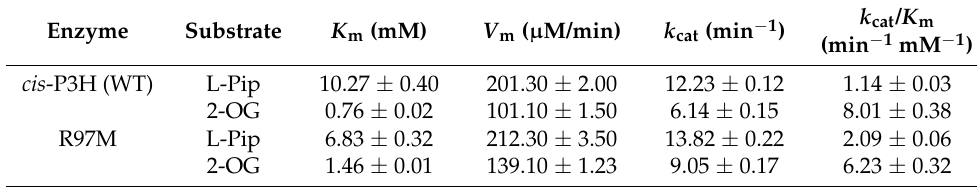
Figure 6. Catalytic performance of the positive mutant and the WT. The blue column represents the results under crude enzyme condition, and the corresponding blue y axis on the left represents the yield of cis -3-L-HyPip (mg/L). The red column represents the results under the pure enzyme condition, and the corresponding red y axis represents the enzyme specific activity ( µ mol/min/mg). Table 2. Kinetic parameters of cis -P3H and R97M.